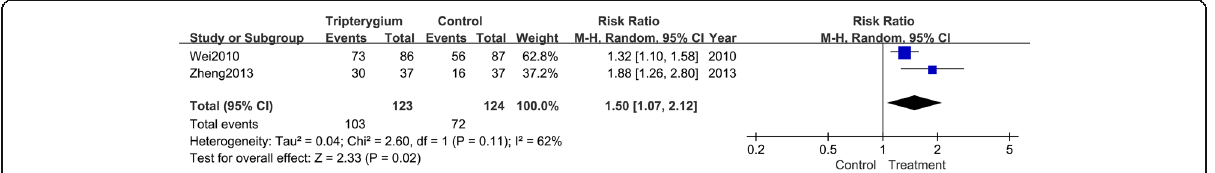
Fig. 8 Meta-analysis of Quality of sleep. CI indicates confidence